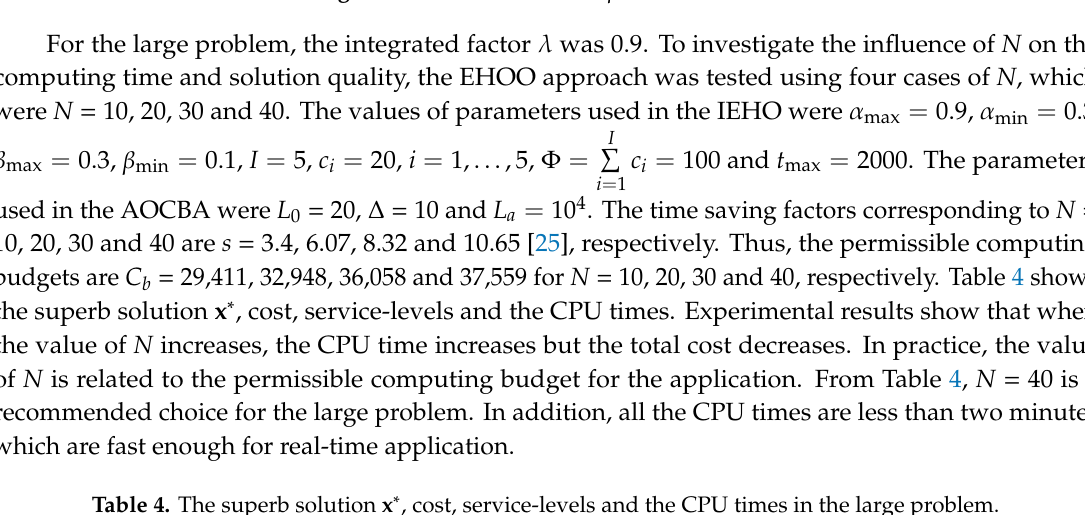
Figure 5. Variations of α and β over iterations.